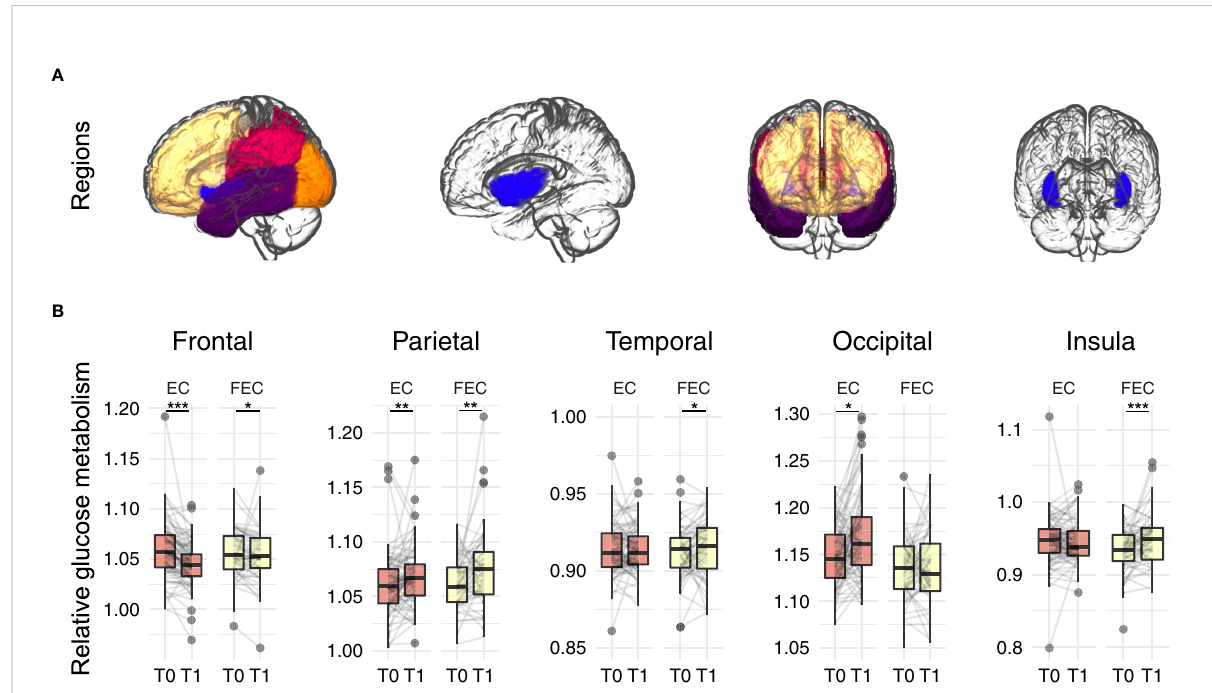
FIGURE 2 Regions of interest analysis of relative glucose metabolism before (T0) and after (T1) neo-adjuvant chemotherapy. (A) regions of interest: frontal (yellow), parietal (red), occipital (orange), temporal (purple) and insular (blue) cortex. (B) Robust mixed effects modelling showed relative decreases in frontal glucose metabolism, while increases where observed for parietal for both EC ( n =100) and FEC ( n =83) treated patients. Additionally, relative increased temporal and insular metabolism was observed for FEC treated patients and increased occipital metabolism for EC patients. Models were corrected for age, type of scanner and years since chemotherapy. P-values were Benjamini-Hochberg corrected for comparing fi ve outcomes. EC = 4 rounds of epirubicin 90 mg/m 2 + cyclophosphamide 600 mg/m 2 ; FEC = 3-6 rounds of 500 mg/m 2 5- fl uorouracil and 4 rounds of epirubicin 100 mg/m 2 + cyclophosphamide 500 mg/m 2 . *pFDR<0.05, **pFDR<0.01,